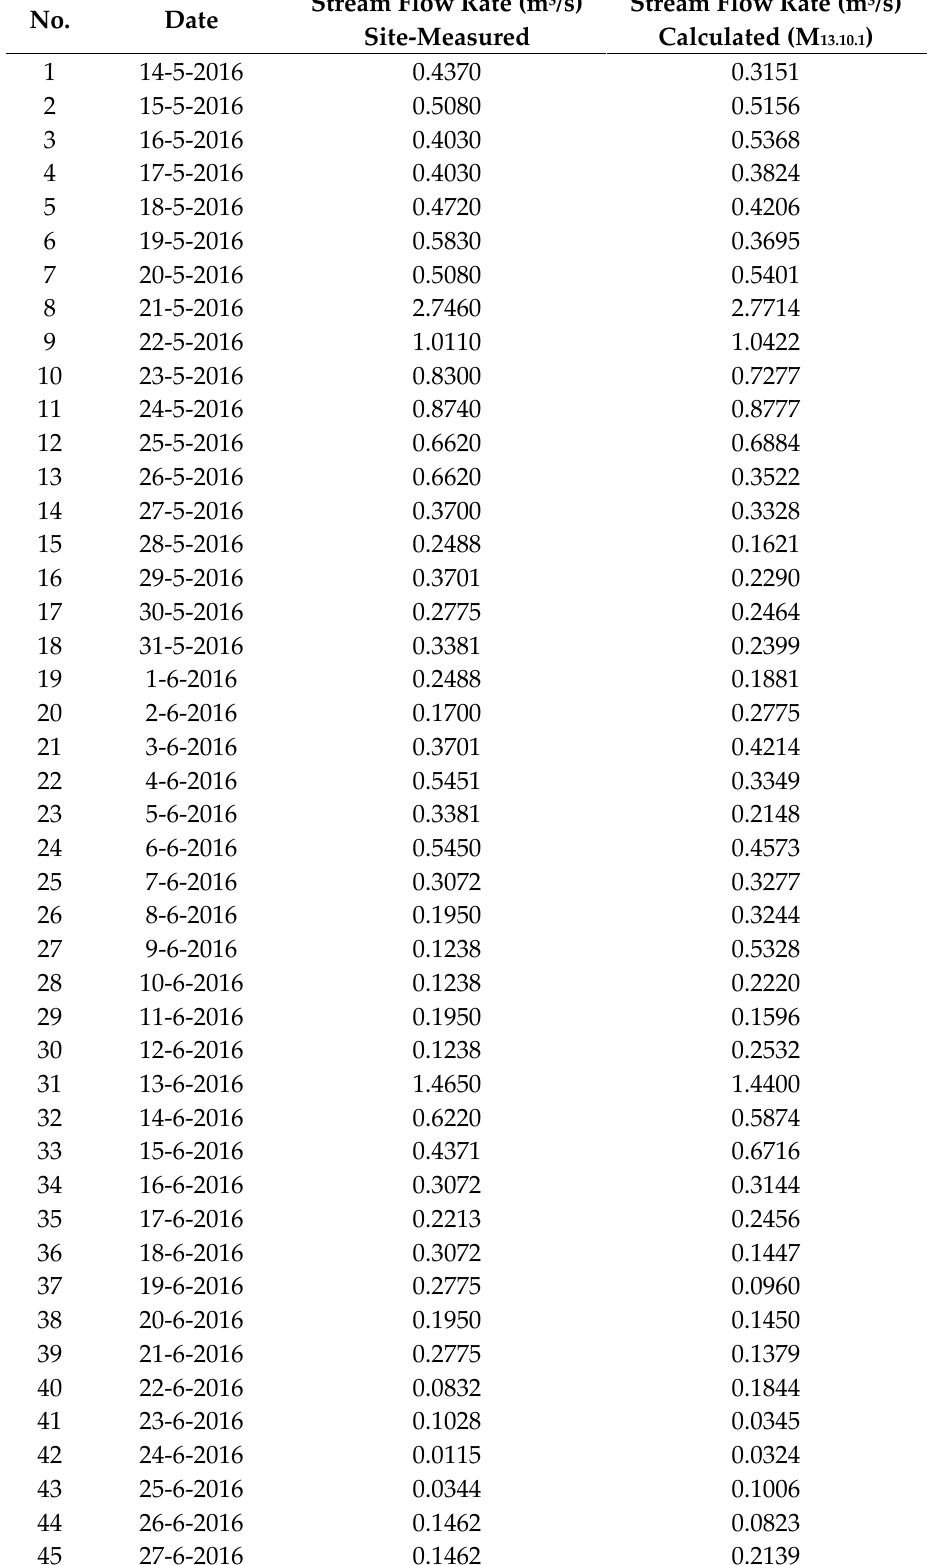
Table A1. Stream flow rate measurements of Perigiali